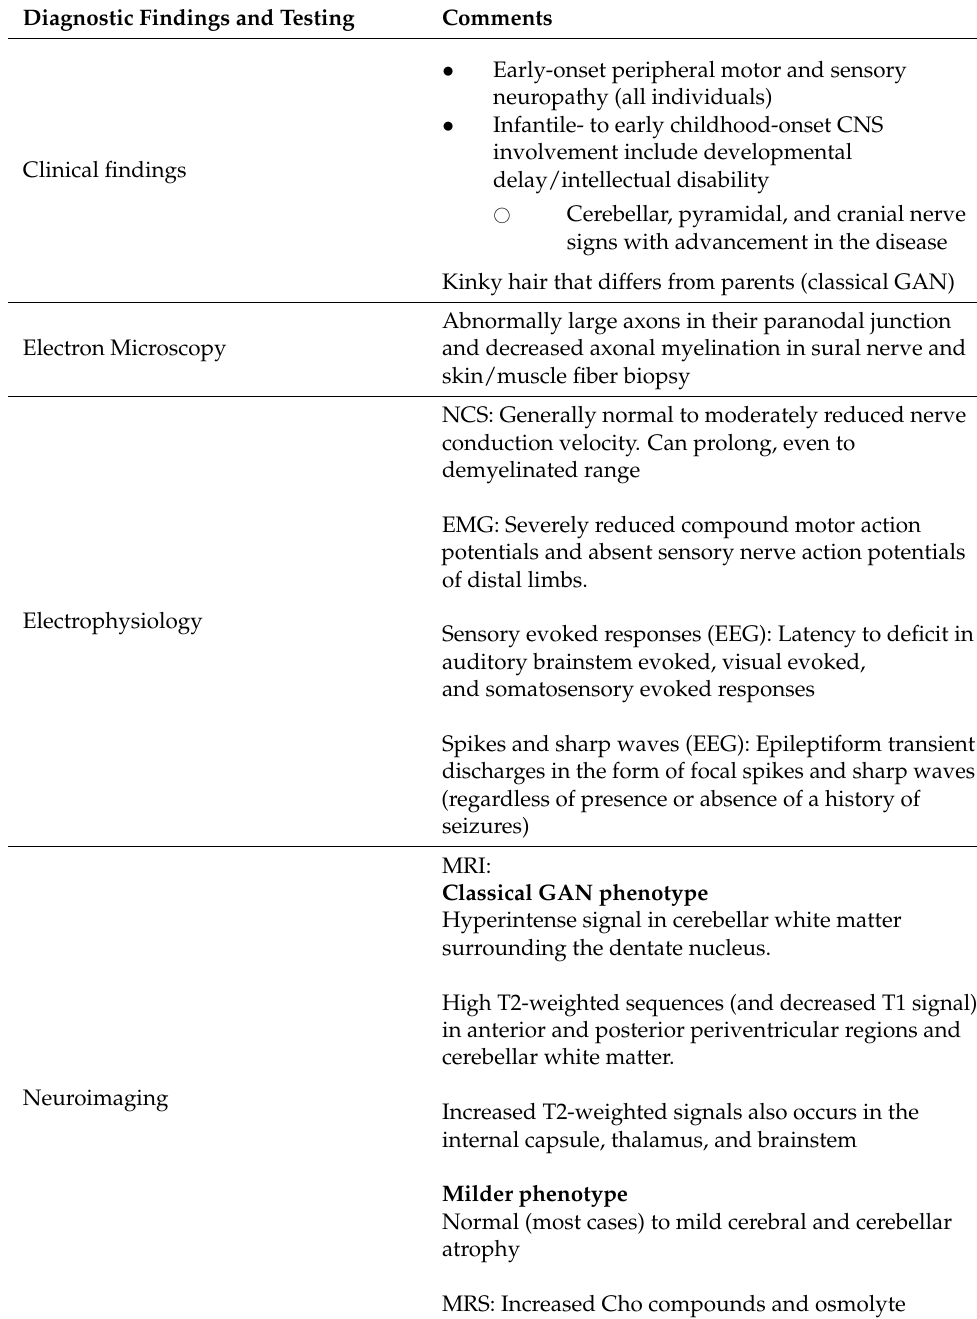
Table 1. Summary of suggestive findings and clinical testing including peripheral nerve biopsy, elec- trophysiologic, and neuroimaging examinations available for diagnosis of giant axonal